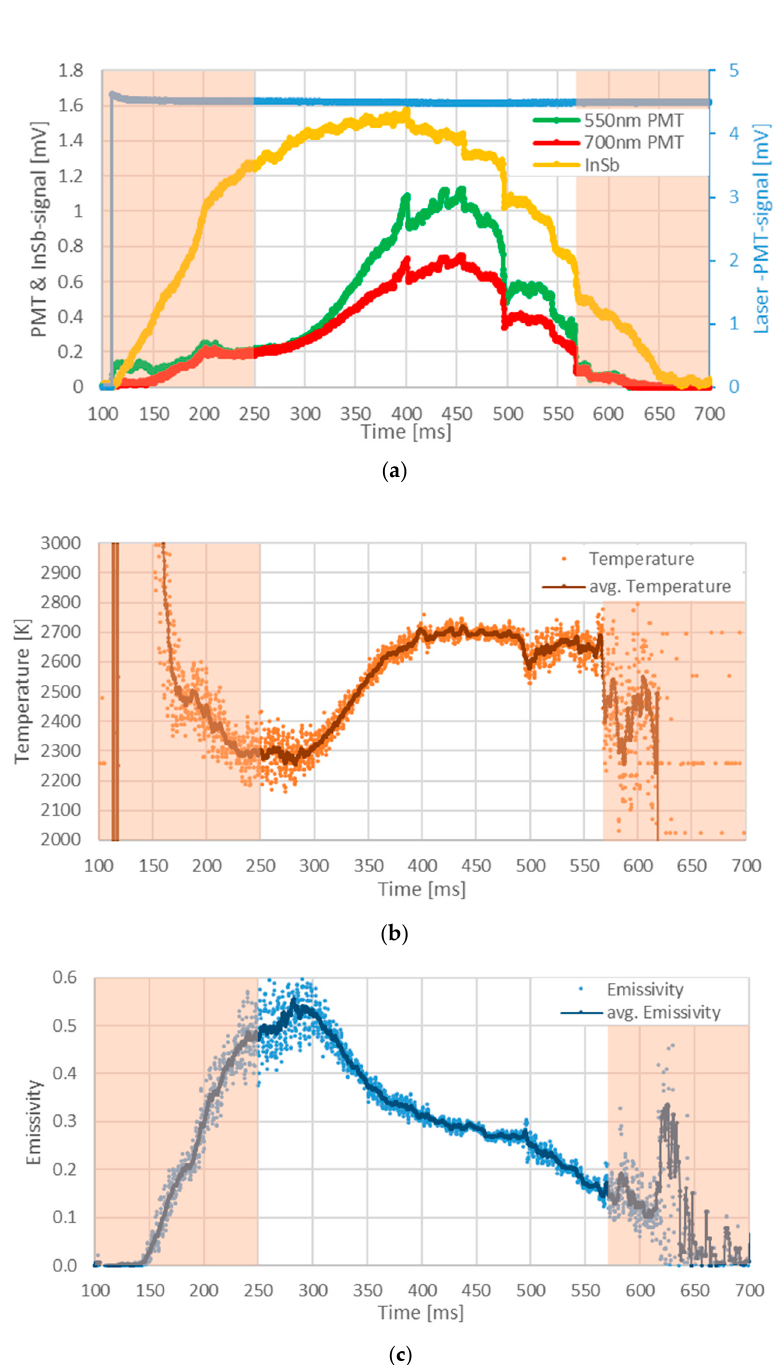
Figure 5. This figure shows an exemplary measured, time-resolved-measured photomultiplier and InSb-detector signals ( a ) and the corresponding calculated temperature ( b ) and emissivity ( c ) of a coal particle. Shaded regions are excluded from the data interpretation.